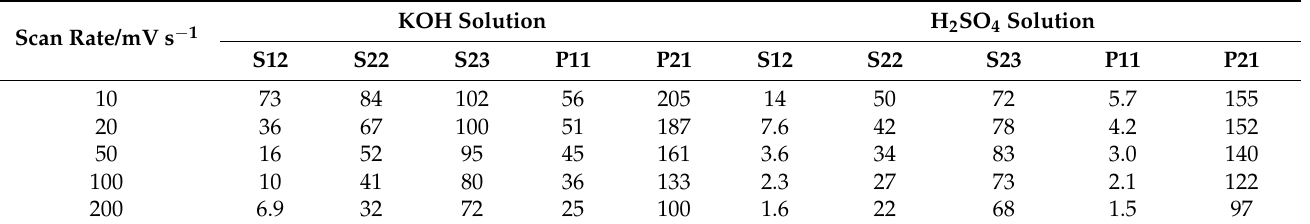
Table 5. Gravimetric capacitances of the investigated samples in aqueous solution at different potential scan rates (given in F g − 1 ).